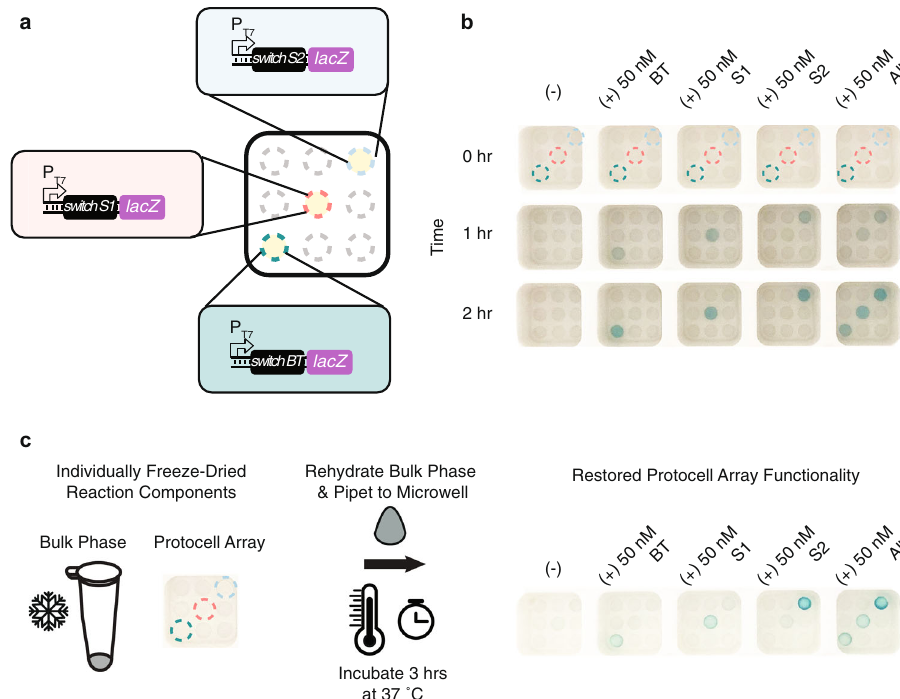
Fig. 6 A membrane-less protocell array meets key criteria for a minimal equipment, fi eld-deployable multiplexed assay. a Schematic of colorimetric protocell array setup for simultaneous detection of multiple nucleic acid sequences. Teal, red, and blue circles indicate micro-basins containing B. theta (BT), Stx1 (S1), and Stx2 (S2) protocell sensors, respectively. Gray circles indicate empty micro-basins without CFE reactions. b Representative sensor activation and pigment production in different bulk phase conditions and at different time points. Images in the same row were taken at the same incubation time. The concentration and the type of DNA trigger(s) used are indicated above each image. Dashed circles indicate micro-basins containing protocell sensors, as shown in a . Results from three biological replicates, as well as their technical triplicates, are provided in Supplementary Fig. 16. c Protocell array functions after lyophilization. Protocells containing CFE reactions coding for sensors of bacterial nucleic acid sequences were lyophilized in micro-basins within microwells, and bulk phase solutions were lyophilized separately. Addition of sample-reconstituted bulk phase to microwells formed the protocells via liquid – liquid phase separation and revived CFE sensing reactions, leading to pigment production after 3 h of incubation at 37 °C.